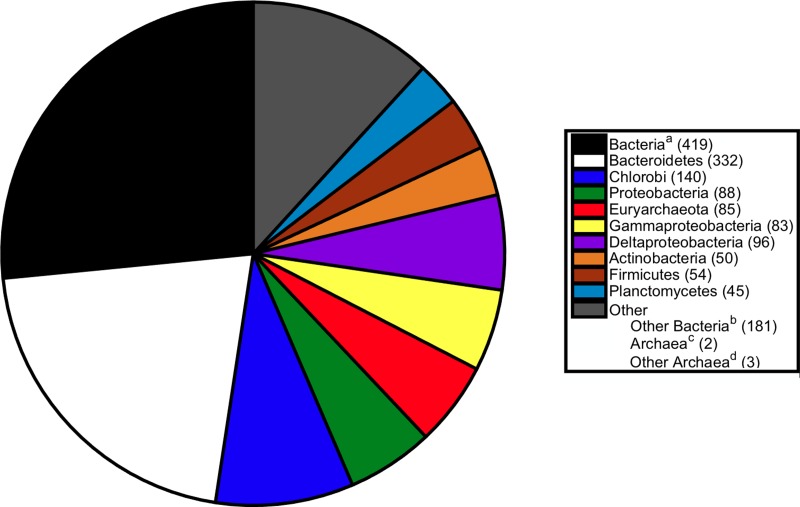
Breakdown of sister relationships to the subtree for S. ruber in 2,274 gene trees generated for strain M13.aBacteria, the sister subtree contained more than one bacterial phyla. bOther Bacteria, the sister consisted of a single bacterial phyla not already listed above. cArchaea, the sister subtree contained more than one archaeal phyla. dOther Archaea, the sister consisted of a single archaeal phyla other than Euryarchaeota.